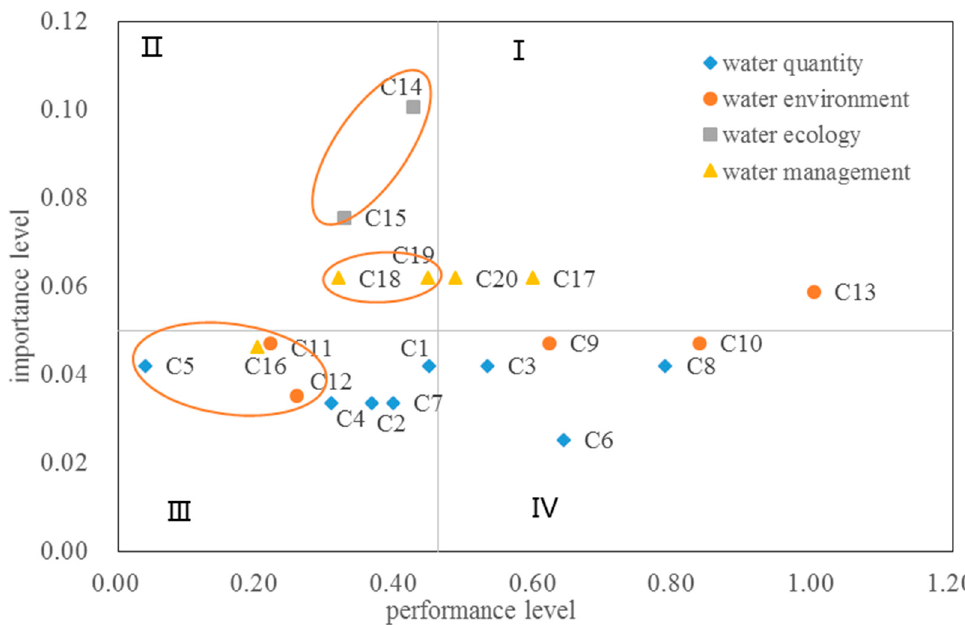
Figure 6. Importance-performance analysis of the WRCC index in towns.